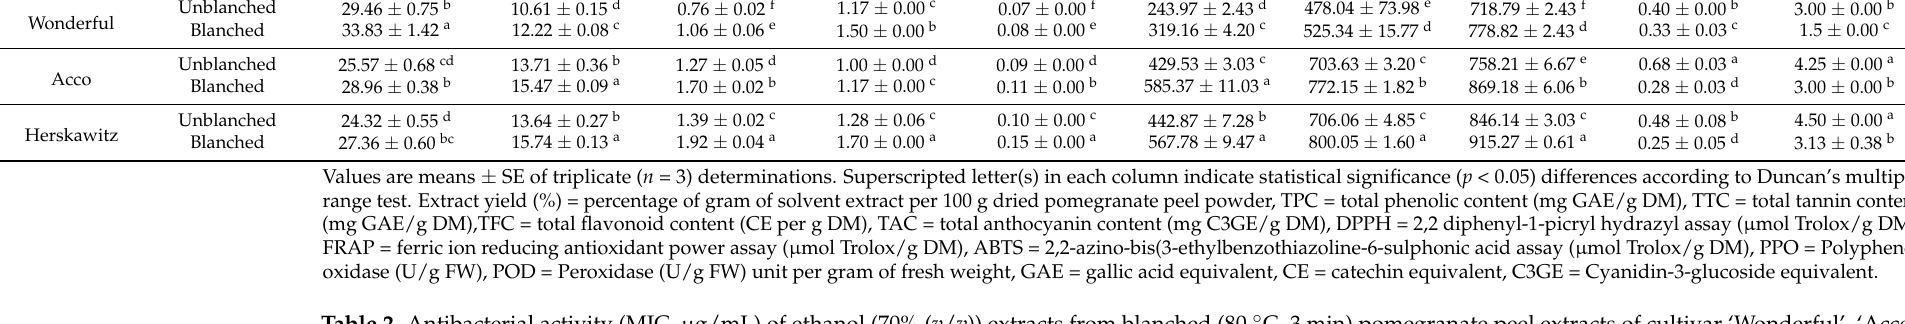
Table 2. Antibacterial activity (MIC, µ g/mL) of ethanol (70% ( v / v )) extracts from blanched (80 ◦ C, 3 min) pomegranate peel extracts of cultivar ‘Wonderful’, ‘Acco’, and ‘Herskawitz’ at commercial